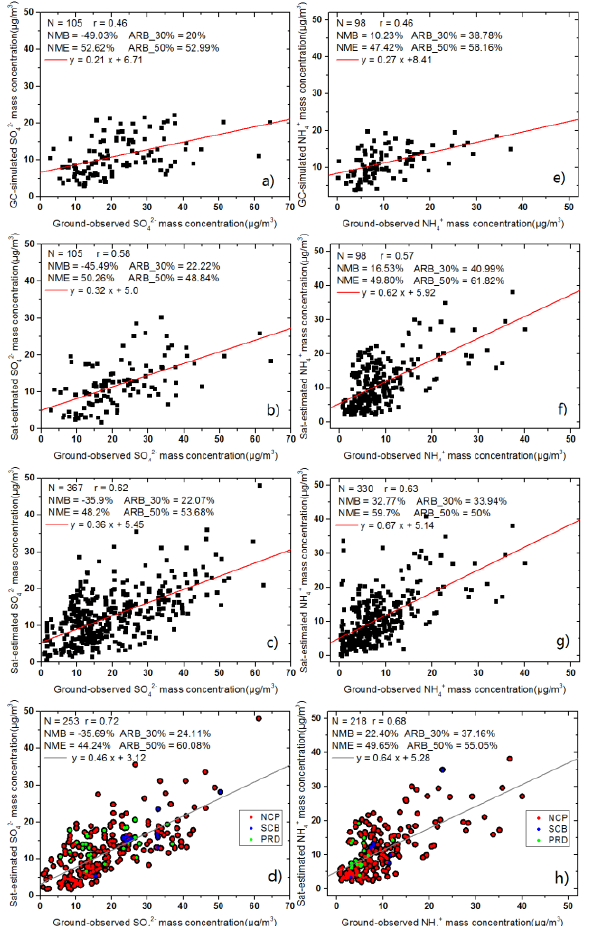
Figure 3. Evaluation of satellite-derived SO 42− ( b , c , d ) and NH 4+ ( f , g , h ) chemical component concentrations (the second line is for 2° × 2.5°; the third line is for 0.1° × 0.1°) and that of model- simulated data ( a , e ) (the first line) using in situ data collected from the literature. The colors of the symbols represent the regions to which the samples belong. Figure 4c, e, g show finer regional patterns and similar variations in the corresponding region in Figure 4a. Zhang et